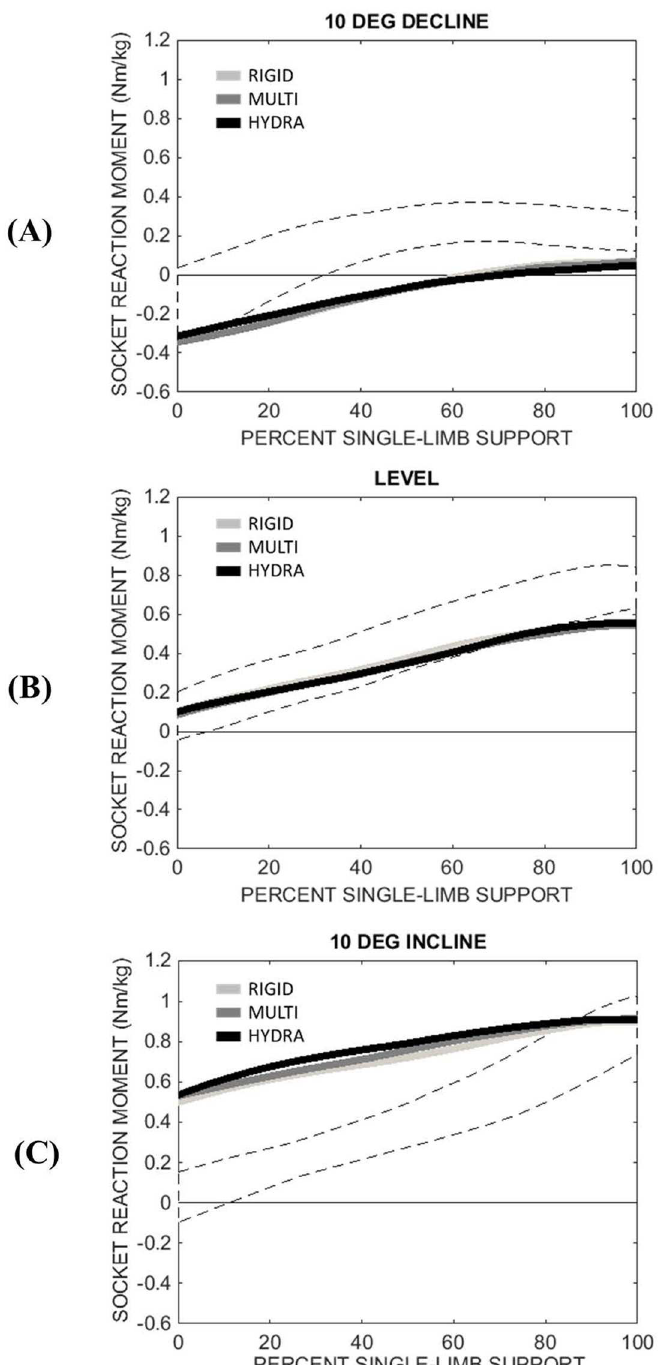
Fig 4. Mean socket reaction moments of subjects with transtibial amputation (n = 7) during single- limb support for the following sloped walking conditions: (A) 10˚ decline, (B) level, and (C) 10˚ incline. Dashedband corresponds to the mean reactionmoment ( ± 1 standarddeviation)of an able-bodied control group (n = 7) at a shank locationequal to the mean, normalized residual-limblength of the amputeegroup. External extensionmoments are definedas